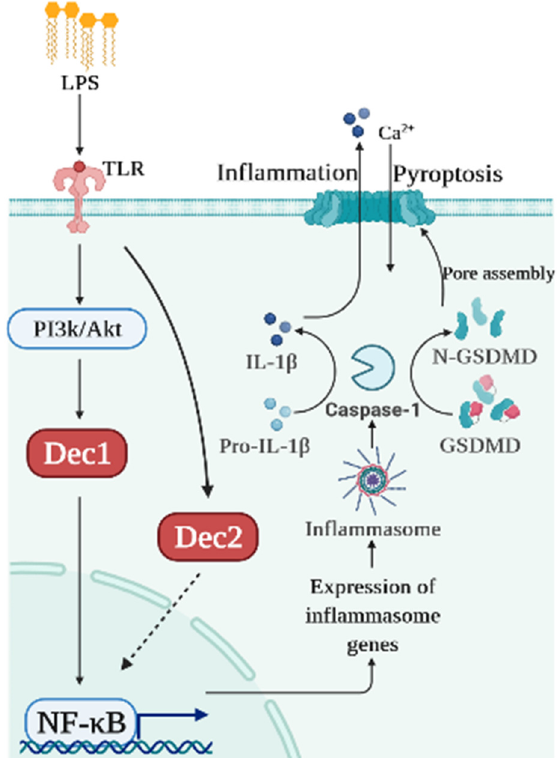
Figure 2. Schematic diagram of the roles of Dec1 and Dec2 in pyroptosis. Bacterial products like LPS induce Dec1 expression and Dec1 upregulates IL-1 β and NF- κ B. Dec2 attenuates the phosphorylation of NF- κ B which, in turn, deactivates caspase-1 and GSDMD.